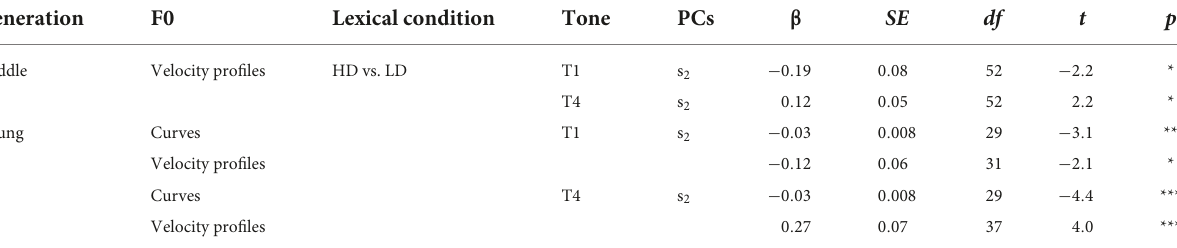
TABLE 6 Summary of linear mixed-effects modeling for F0 curves and F0 velocity profiles in the lexical condition of homophone neighborhood density for T1 and T4. Generation F0 Lexical condition Tone PCs β SE Middle Velocity profiles